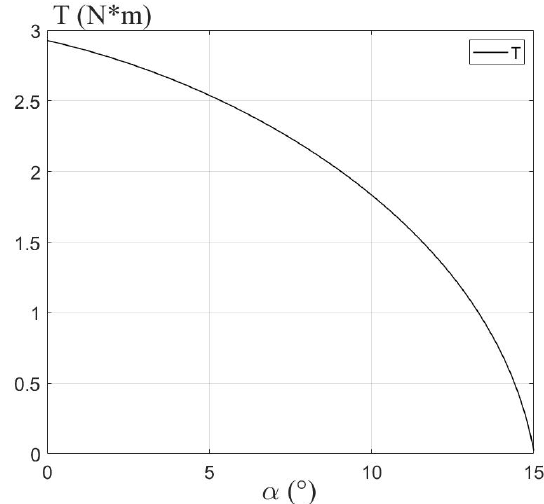
Figure 14. The curve of T changing with the pitch angle α of the